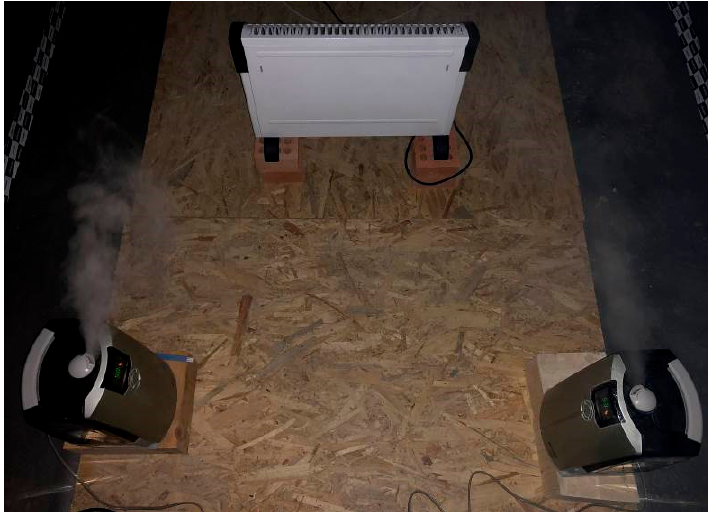
Figure 6. Box indoor hygrothermal control equipment.